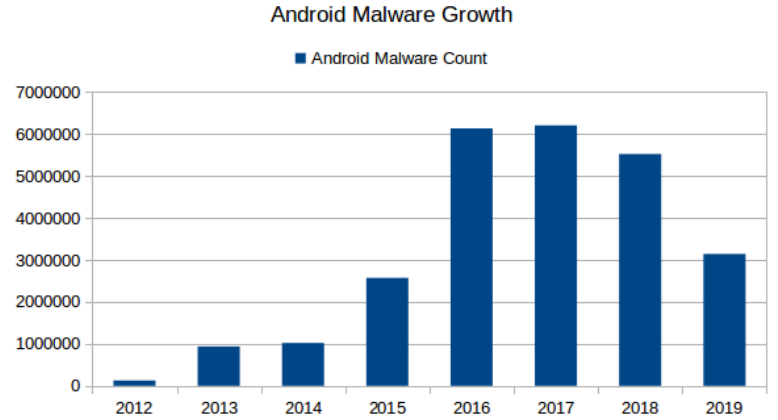
Figure 2. Android Malware Growth 2012–19